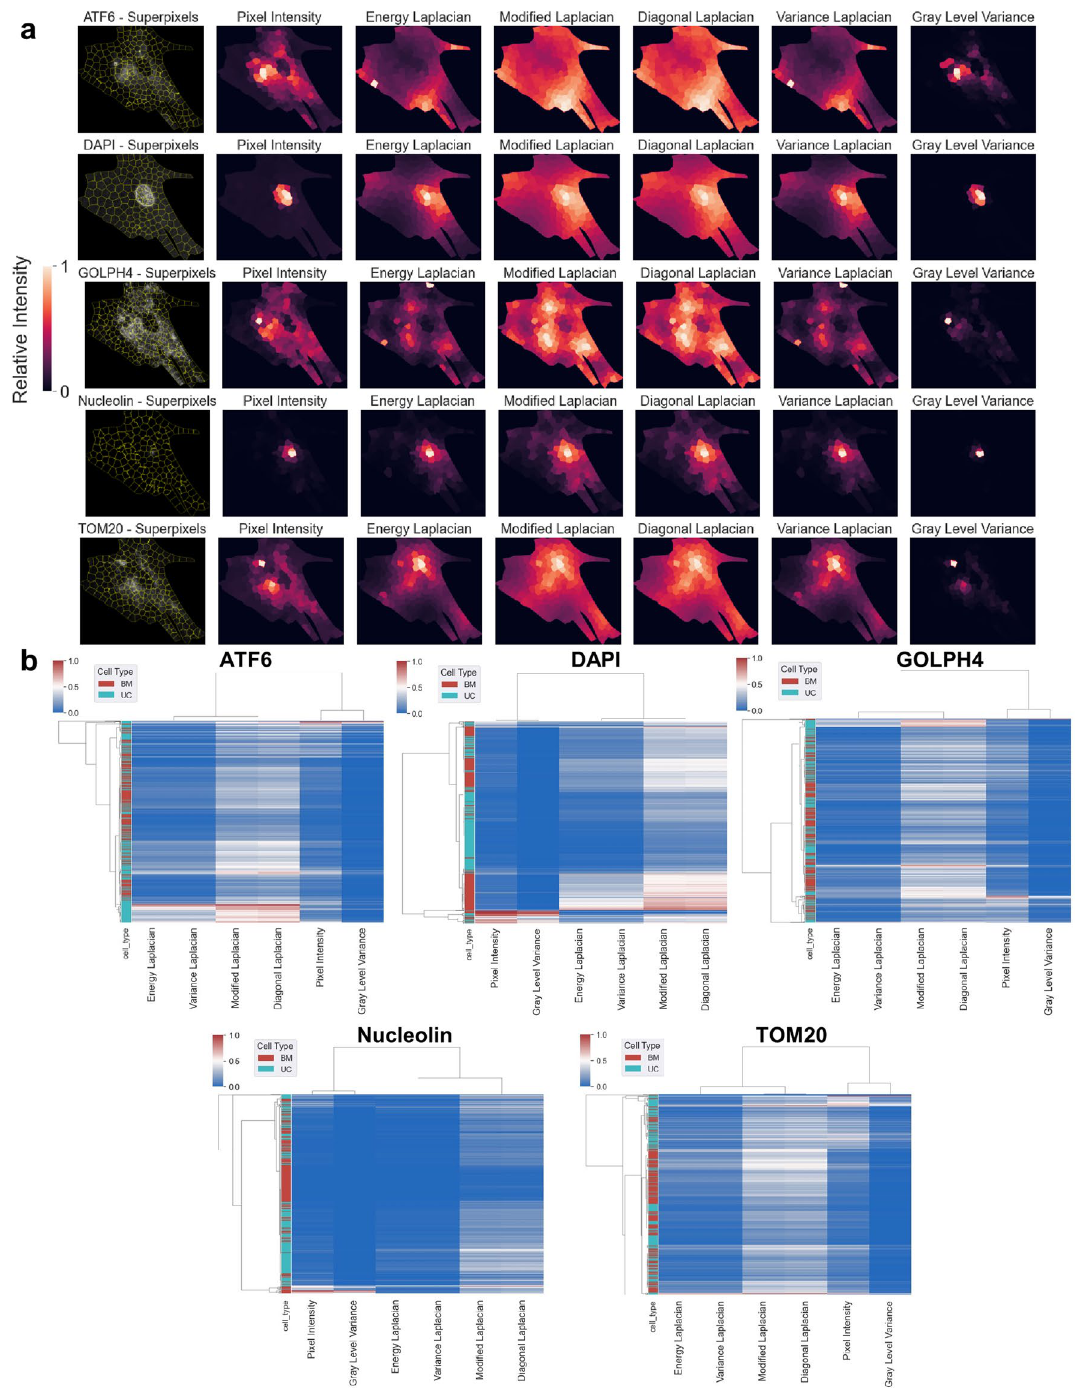
Figure 6. Superpixel segmentation and texture analysis of organelle markers in BM MSCs and UC MSCs. ( a ) Superpixel segmentation and texture features using various cost functions (Pixel Intensity, Energy Laplacian, Modified Laplacian, Diagonal Laplacian, Variance Laplacian, and Gray Level Variance) calculated on superpixels for each marker of a single BM MSC. Each column represents a different superpixel method. Segmentation identifies subcellular, regional hotspots of organelles. Modified Laplacian and diagonal Laplacian create a more spread signal for all markers. Pixel intensity and variance Laplacian reveal discontinuous hotspots of GOLPH4 , ATF6, and TOM20. ( b ) Heatmap of texture feature values for each superpixel in 7 BM MSCs and 7 UC MSCs for each marker. Each row denotes a single superpixel, and the column contains texture feature values for the corresponding superpixel. The feature values range from 0 (blue) to 1 (red) in each heatmap. Modified Laplacian and diagonal Laplacian yield the largest feature values. Each heatmap represents a different marker. UC and BM MSCs show similar overall patterns across various superpixels, implying that earlier, quantified differences are more minute and superpixel methods disguise these small differences when